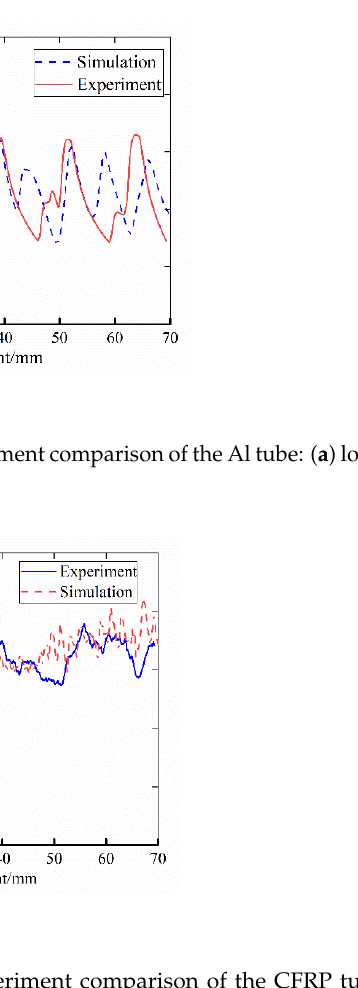
( b ) Figure 9. Simulation and experiment comparison of the CFRP-Al hybrid tube: ( a ) load – displacement curve; ( b ) compari- son of deformation modes.